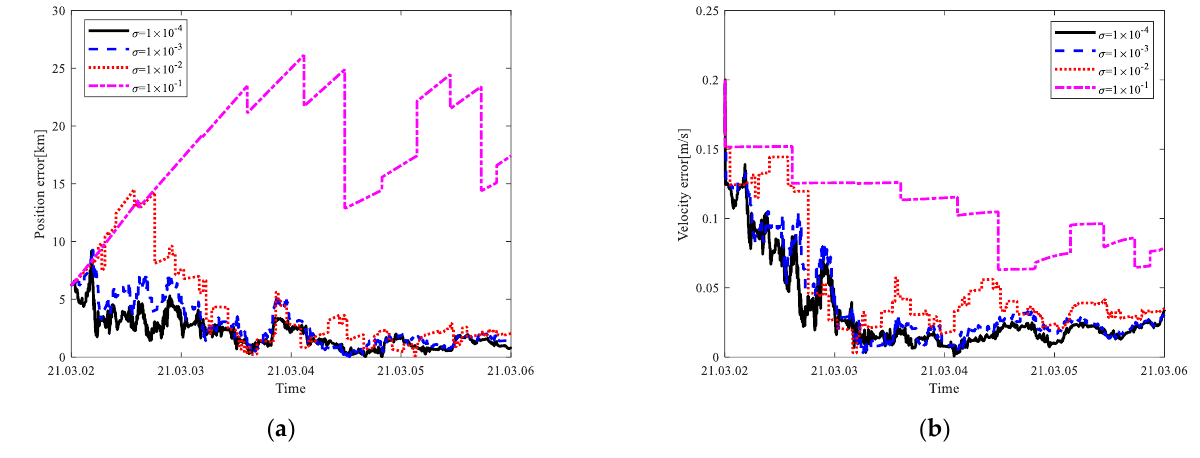
Figure 4. Navigation results of the parameter-dependent event-triggered mechanism based on measurement. ( a ) Position error. ( b ) Velocity error. Table 4. Navigation results with different σ .